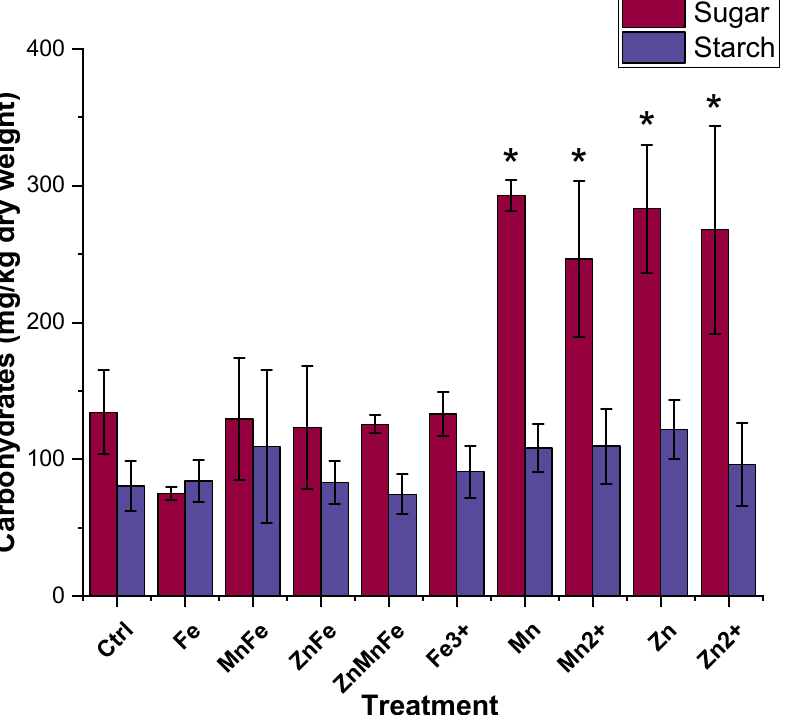
Figure 6. Tomato fruit carbohydrate profile after plant exposure to either Fe 3 O 4 (Fe), MnFe 2 O 4 (MnFe), ZnFe 2 O 4 (ZnFe), Zn 0.5 Mn 0.5 Fe 2 O 4 (ZnMnFe), Mn 3 O 4 (Mn), ZnO (Zn), or their ionic counter- parts; n = 4; * denotes statistical difference between control and treatments.